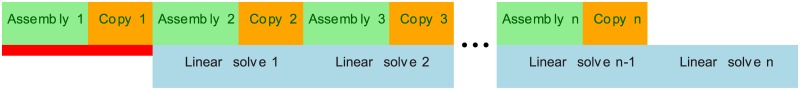
This figure shows a communication hiding pattern that interleaves the assembly (green; on the GPU) and copy (orange; data transfer from the GPU to the CPU) with the linear solve (blue; on the CPU).The red areas constitute the remaining overhead that decreases as we divide our problem into more and more slices.